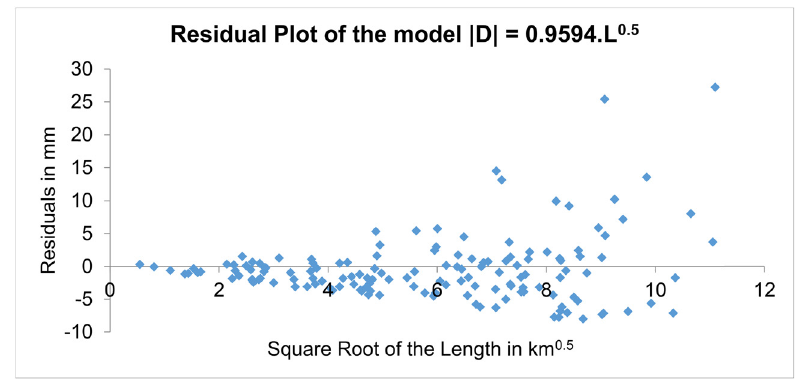
Figure 1: Heteroscedastic pattern of the residuals of the regression model | D | = 0.9594 · L , where | D | denotes the absolute di ff erence between both measurements of the height between the terminals of a line with length L. The regression model is based on 146 lines given by Kääriäinen ( 1966, Table IX ) .